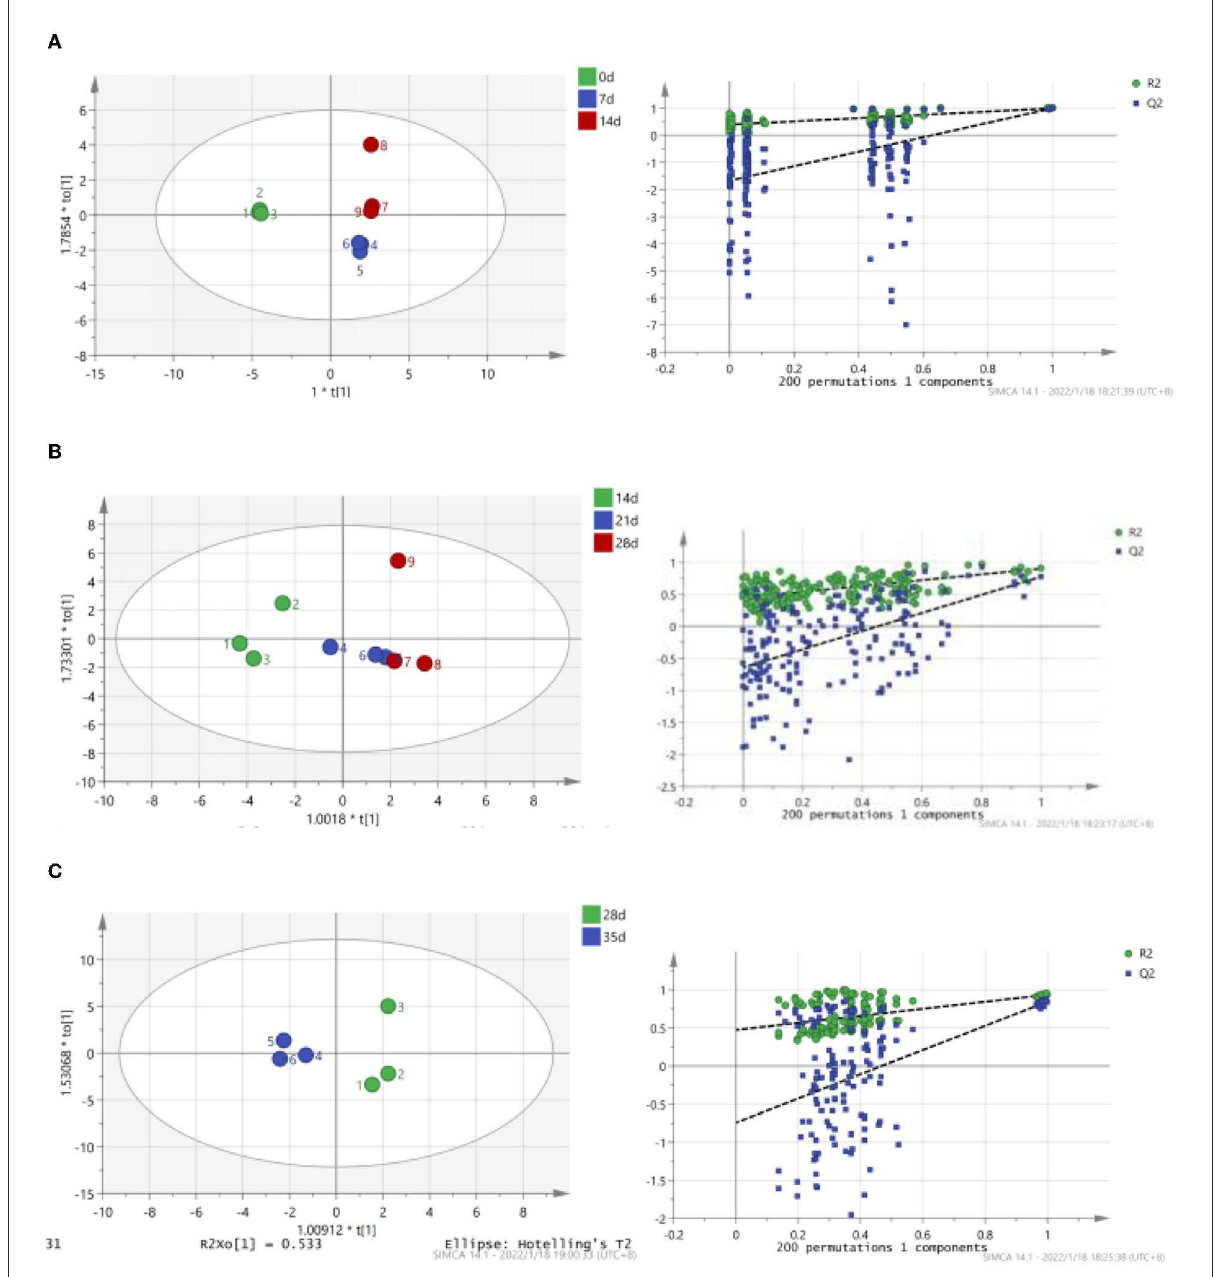
caused the degradation of large molecules of protein to form small peptides and free amino acids. Therefore, it could lead that the contents of TCA soluble peptide showed a significant upward trend. Compared to the OPLS, which were established by analyzing the interaction between pH, endogenous protease, and TCA soluble peptides and free amino acid (Figures 3C,